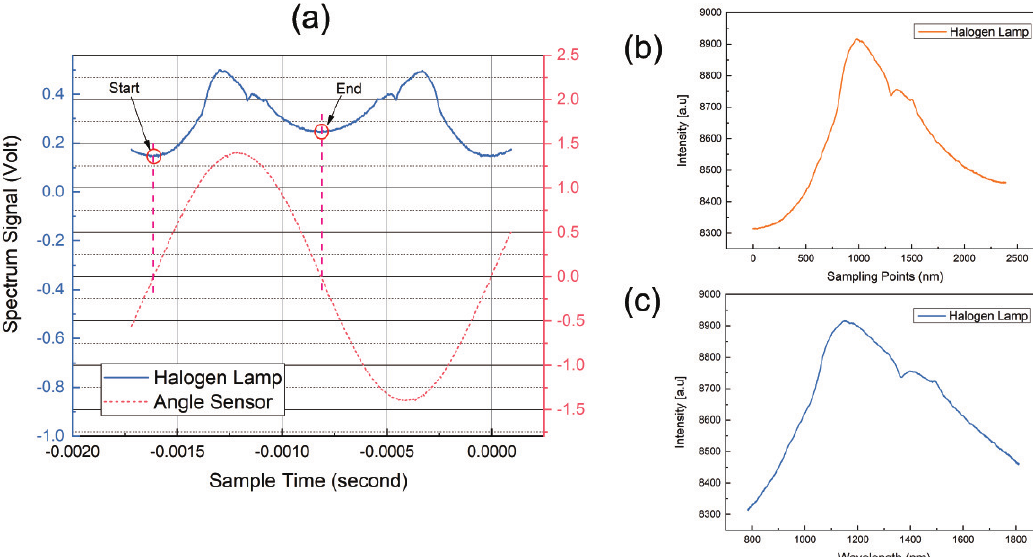
Figure 3. ( a ) Two full scans within one mirror oscillation; ( b ) time-dependent spectrum of a halogen lamp and ( c ) wavelength-dependent spectrum of a halogen lamp using